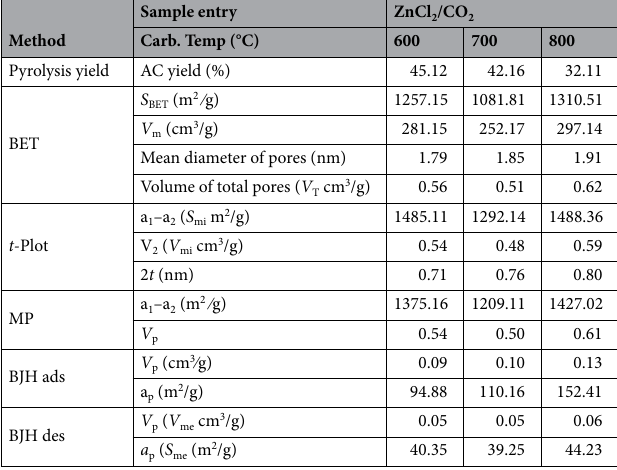
Table 1. Analysis of PPACs surface area using various models.